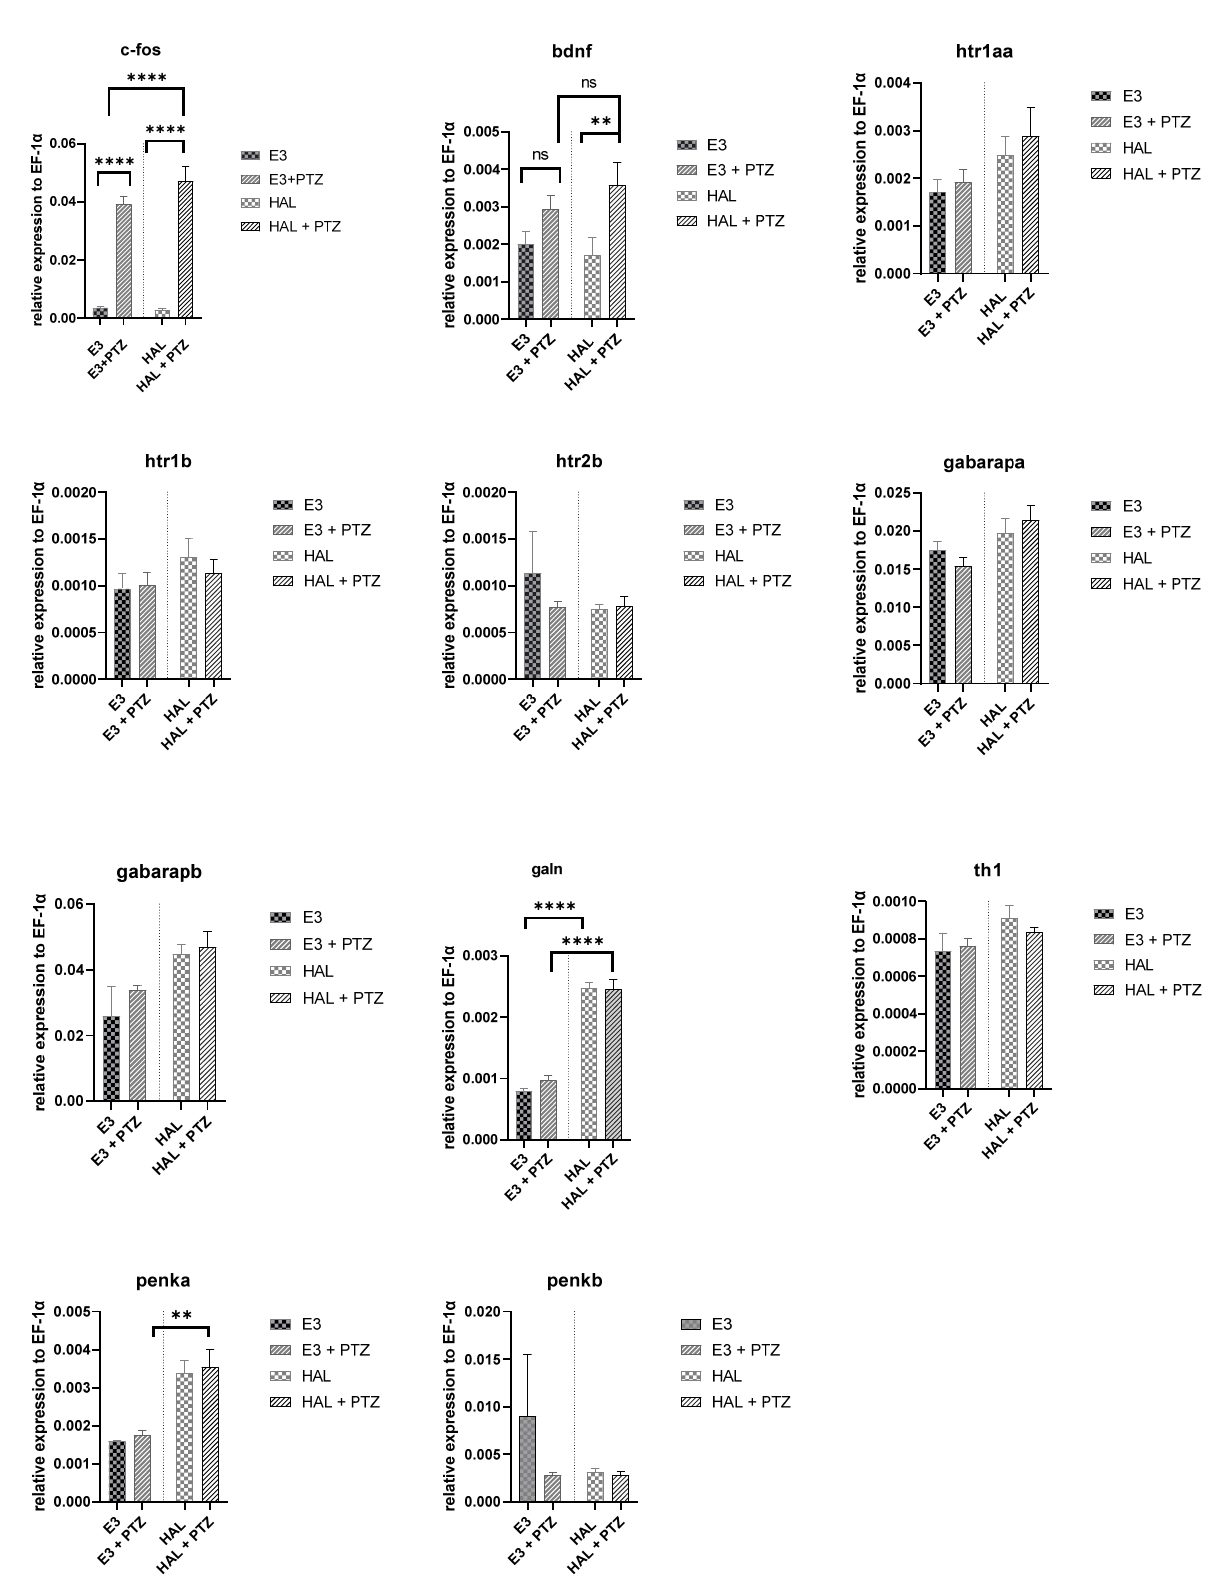
Figure 5. Changes of gene expression for control and halfordin-treated group before and after PTZ treatment. The one-way ANOVA with SEM and post-hoc Tukey test (** p < 0.01, **** p < 0.0001, ns: not significant) was used to calculate significance; n = 3.